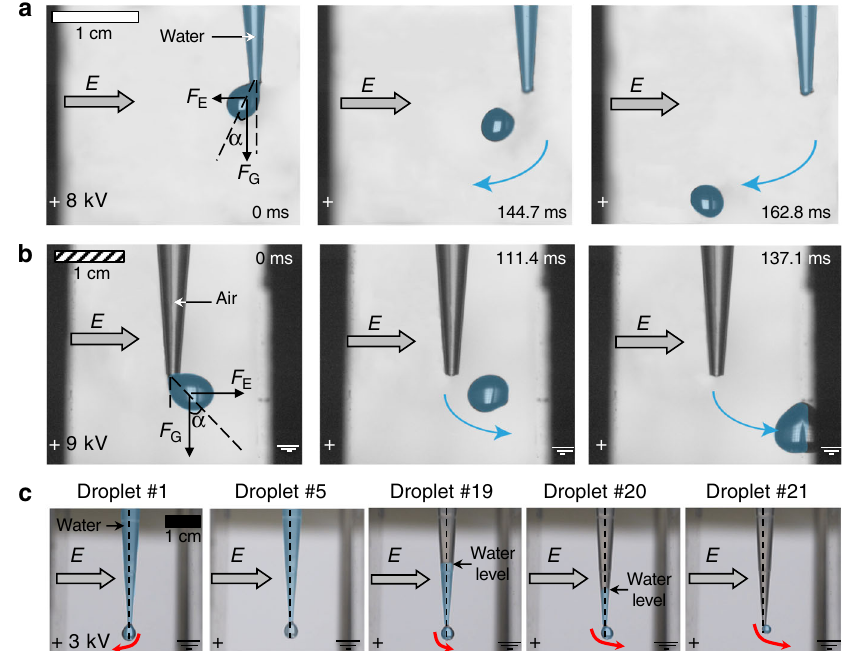
Fig. 2 Pendant water droplets under uniform electric fi elds. a When the capillary is water- fi lled, the pendant droplets are de fl ected towards the positively charged plate (we emphasize water using false blue color). The direction of the electric fi eld, E , is shown by the gray arrows; free-body diagrams represent the forces due to gravity ( F G ) and electrostatics ( F E ) acting on the water droplets. b When the capillary is air- fi lled, the droplets are repelled by the positively charged plate. c Photographs of sequential 10 μ L water droplets dispensed from a partially fi lled polypropylene capillary (initial volume: 200 μ L) under a uniform electric fi eld. The red arrows point to the directions of the droplets ’ de fl ections and the dashed vertical lines are drawn to assist in the